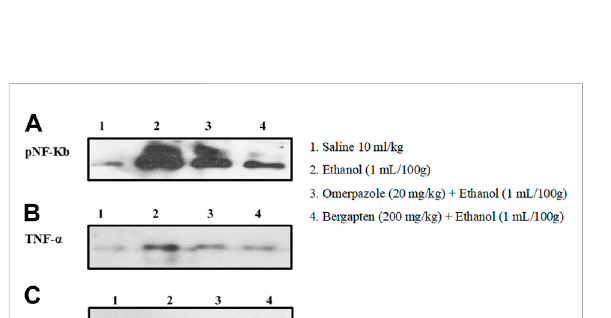
FIGURE 11 Pictorial representation showing inhibitory effect of bergapten and omeprazole groups against (A) phosphorylated nuclear factor kappa B (pNF-Kb), (B) tumor necrosis factor alpha (TNF- α ), (C) cyclooxygenase 2 (COX-2), and (D) β -actin expression in ethanol-treated gastric tissues using western blot techniques, where 1 indicates saline group, 2 indicates the expression in ethanol groups, 3 indicates omeprazole group, and 5 indicates bergapten (200 mg/kg)